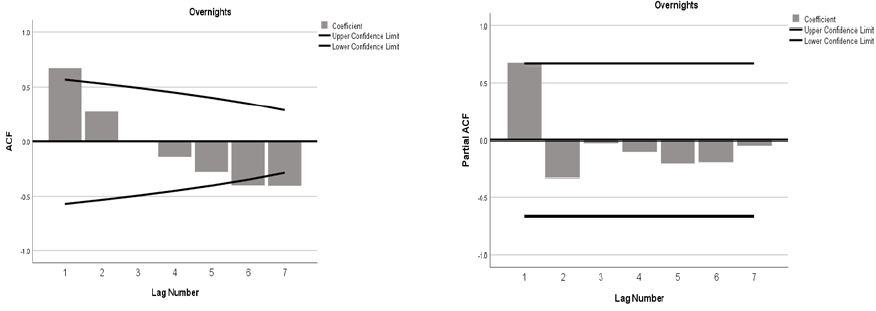
Figure 8. Correlogram of international overnights ACF I PACF.